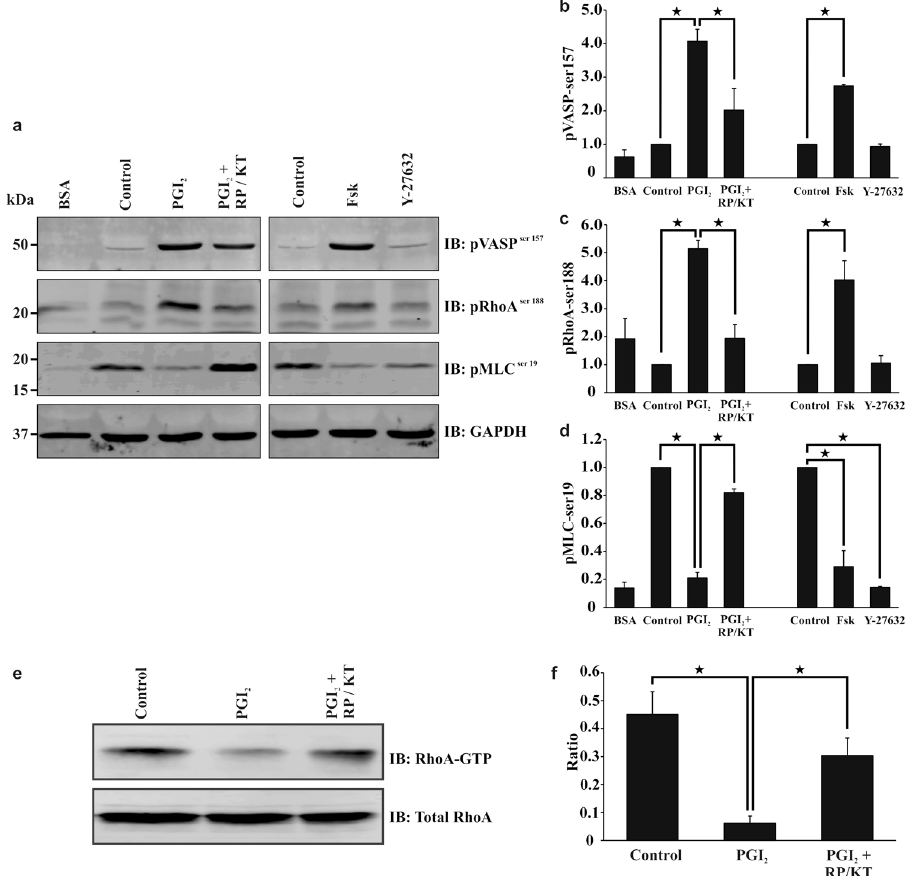
Figure 6. PGI 2 induces a PKA signalling response in spread platelets. Platelets (2 × 10 8 /ml) were spread on 100 μ g/ml fibrinogen for 25 minutes in the presence or absence of PKA inhibitors 100 μ M RP-8CPT-cAMP (RP) and 2 μ M KT5720 (KT), before being washed with PBS. ( a ) The platelets were then treated with tyrodes containing 10 nM PGI 2 with or without PKA inhibitors (100 μ M RP-8CPT-cAMP and 2 μ M KT5720), or 1 μ M forskolin, or Y27632 (10 μ M), for a further 10 minutes. The samples were then lysed with laemelli buffer before being western blotted for pVASP ser159 , pMLC ser19 , pRhoA ser188 , and GAPDH. Cropped gel Images are representative of at least three experiments (full length gels are illustrated in Supplementary Figure S6). ( b – d ) Densitometry for the western blots; pVASP ser159 , pMLC ser19 and pRhoA ser188 using GAPDH as the loading control. The ratios were standardised to the control. ( e ) Spreading the platelets as above, they were treated with tyrodes containing 10 nM PGI 2 with or without PKA inhibitors 100 μ M RP-8CPT-cAMP and 2 μ M KT5720 for a further 10 minutes. The samples were then lysed, before the addition of RhoA GTP beads. Samples were then western blotted for active RhoA and total RhoA. Cropped gel Images are representative of at least three experiments (full length gels are illustrated in Supplementary Figure S6). ( f ) Images of RhoA pull down were analysed for densitometry (full length gels are illustrated in Supplementary Figure S6). Analysis is an average of at least n = 3 experiments. p <